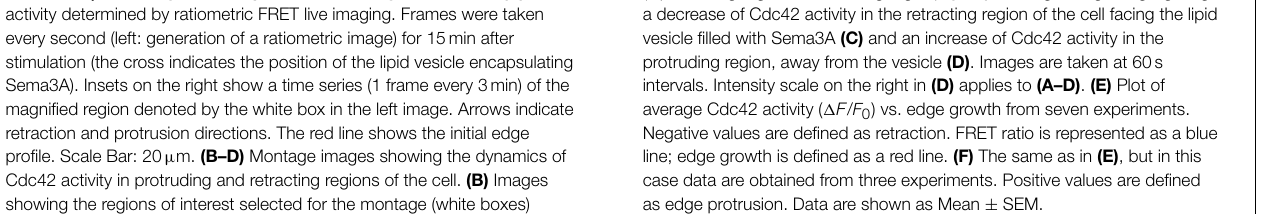
(i, protruding region; ii, retracting region). (C,D) Montage images highlighting a decrease of Cdc42 activity in the retracting region of the cell facing the lipid vesicle filled with Sema3A (C) and an increase of Cdc42 activity in the protruding region, away from the vesicle (D) . Images are taken at 60s intervals. Intensity scale on the right in (D) applies to (A–D) . (E) Plot of average Cdc42 activity ( 1 F / F 0 ) vs. edge growth from seven experiments. Negative values are defined as retraction. FRET ratio is represented as a blue line; edge growth is defined as a red line. (F) The same as in (E) , but in this case data are obtained from three experiments. Positive values are defined as edge protrusion. Data are shown as Mean ±